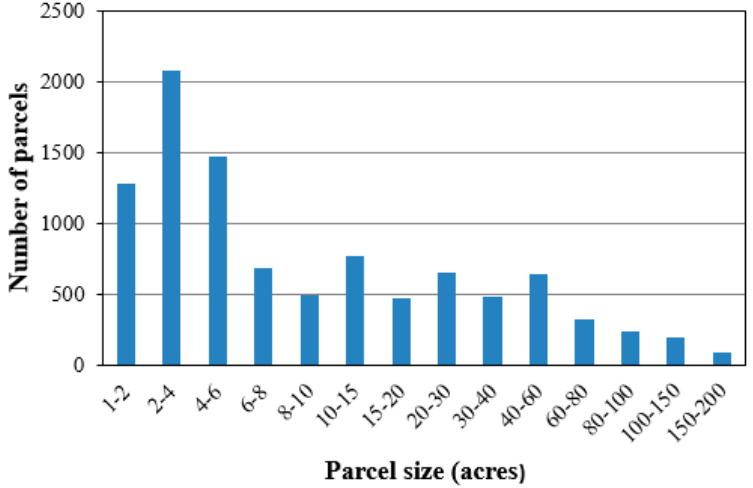
Figure 8. Private parcels were divided into 14 bins for exploring the relationship between forest attributes and parcel size. A bin of a-b acres includes all parcels of a ≤ parcel size <b.